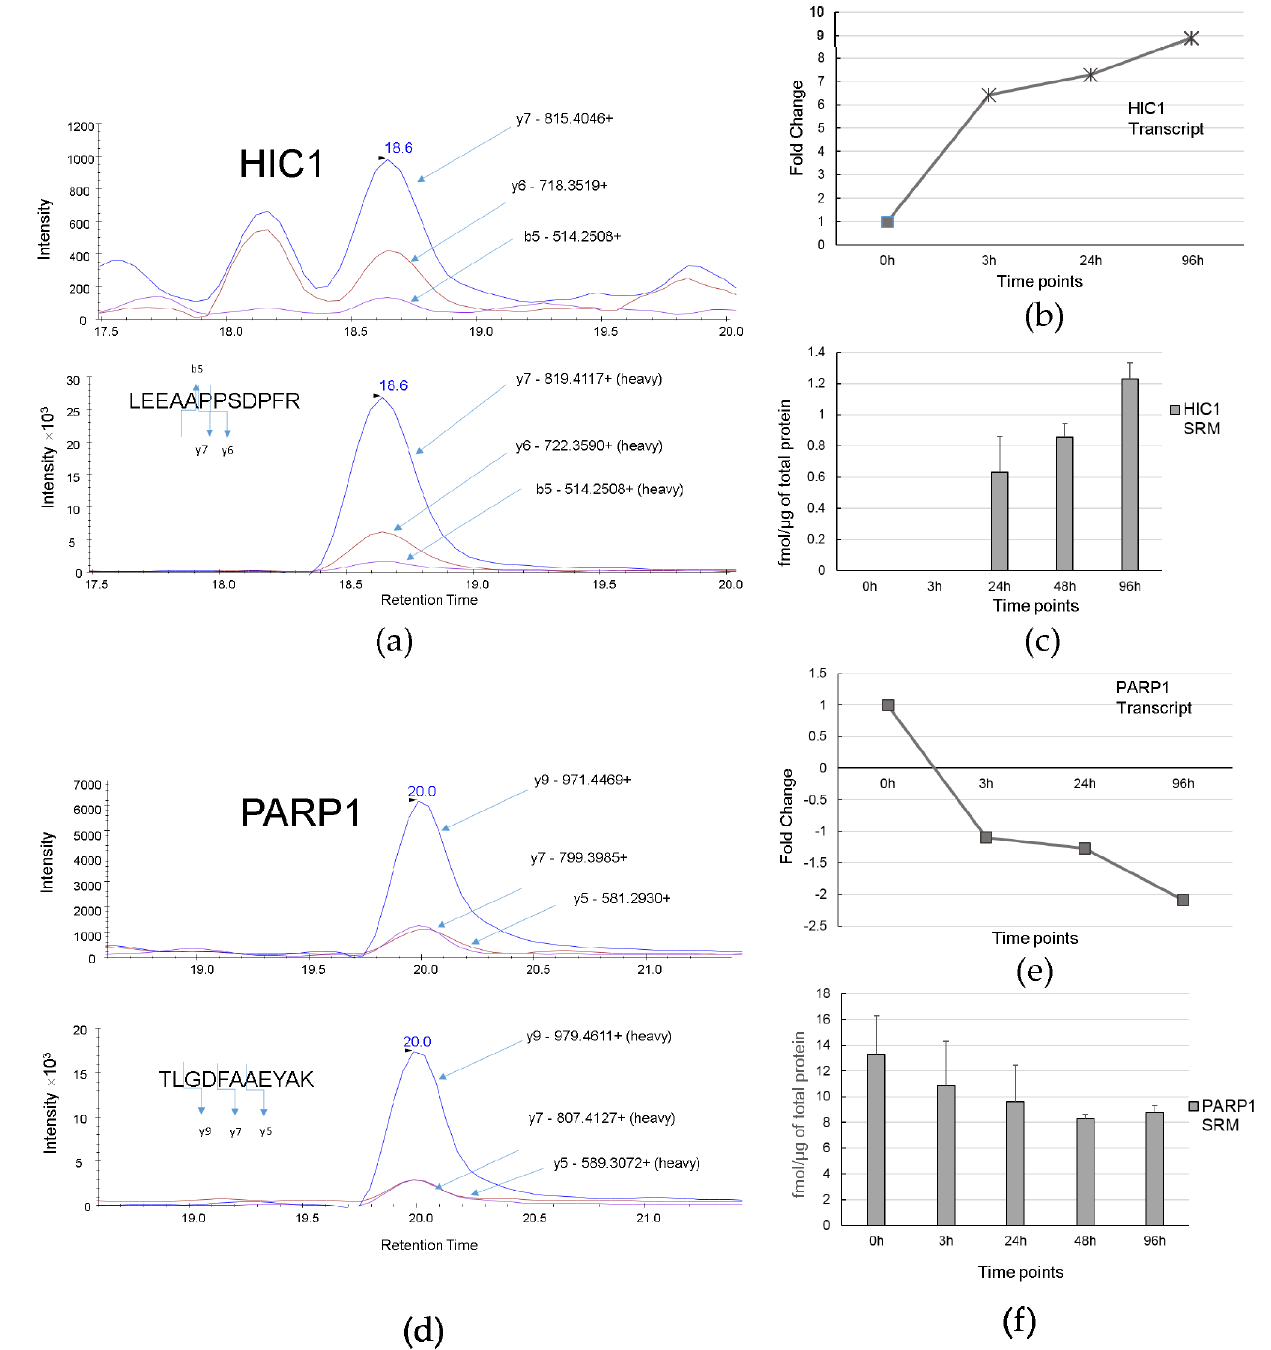
Figure 7. HIC1 and PARP1 expressions at ATRA-induced granulocytic differentiation. ( a ) Trace of SRM transitions for native and stable isotope labeled peptide standard LEEAAPPSDPFR of HIC1. ( b ) Profile of transcript expression HIC1 during HL60 differentiation (fold change ≥ 2, p -value ≤ 0.05 at 3 h, 24 h, and 96 h). ( c ) Protein expression level of HIC1 obtained by SRM (three biological replicates) at 3 h, 24 h, 48 h, 96 h. ( d ) Trace of SRM transitions for native and standard isotopically-labeled peptide TLGDFAAEYAK of PARP1. ( e ) Profile of transcript expression PARP1 during HL60 differentiation (fold change ≥ 2, p -value ≤ 0.05 at 96 h). ( f ) Protein expression level of PARP1 obtained by SRM (three biological replicates) at 3 h, 24 h, 48 h, 96 h.